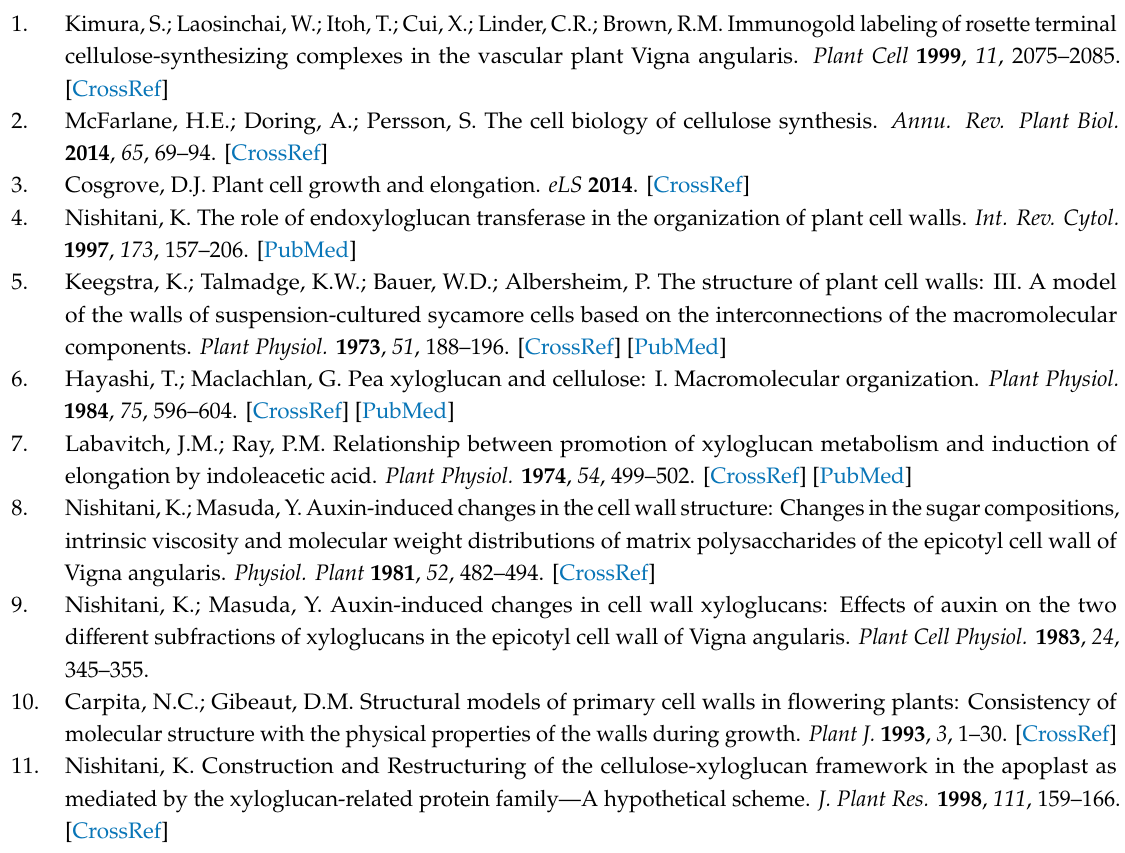
Figure S1: Changes in coe ffi cient of variation (CV) of fluorescence intensity distribution of Calcofluor-stained network in the Taxol treatment during cell wall regeneration, Figure S2: Correlation of mean intensity with skewness and CV of the regenerated cellulose network in protoplasts incubated in the regeneration medium for 24